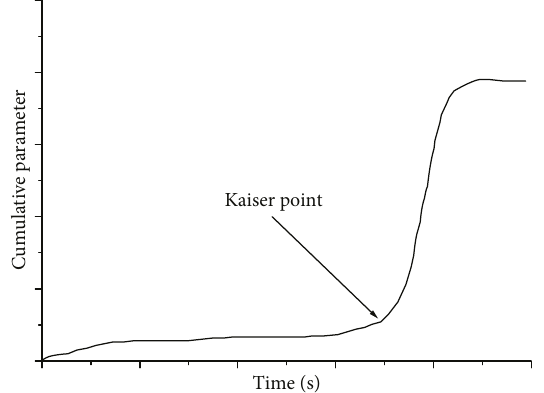
Figure 2: Kaiser point interpretation of the in fl ection point of the accumulated parameter.